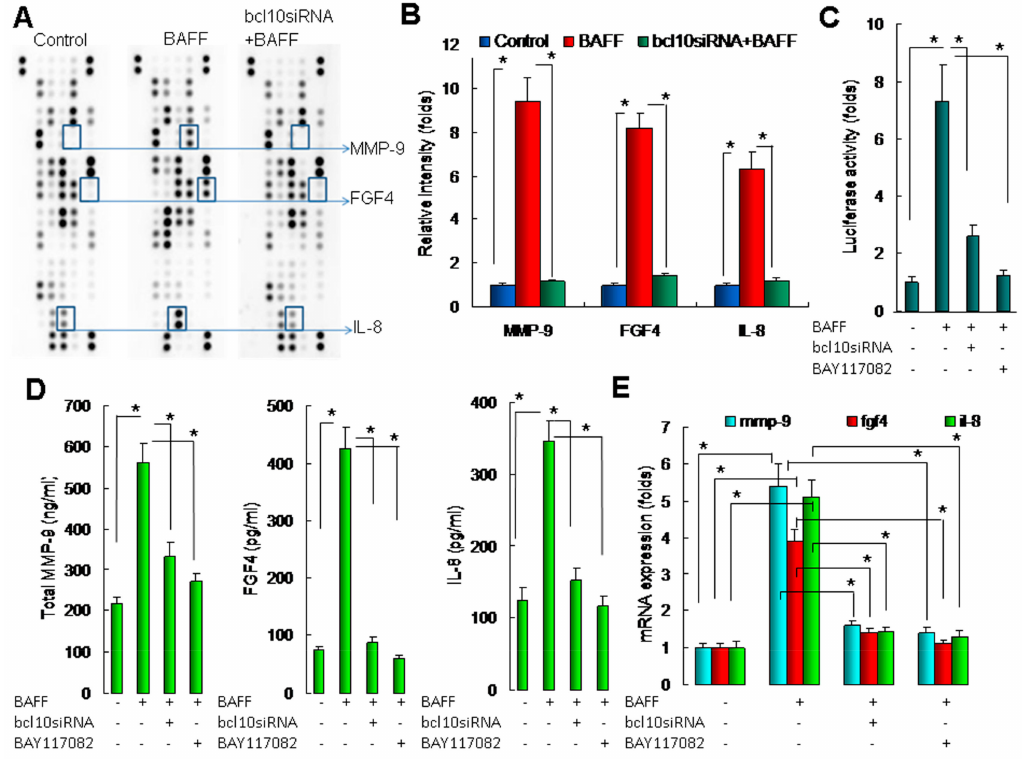
Figure 4. BAFF stimulated Matrix metalloproteinase-9 (MMP-9), Fibroblast growth factor 4 (FGF4),